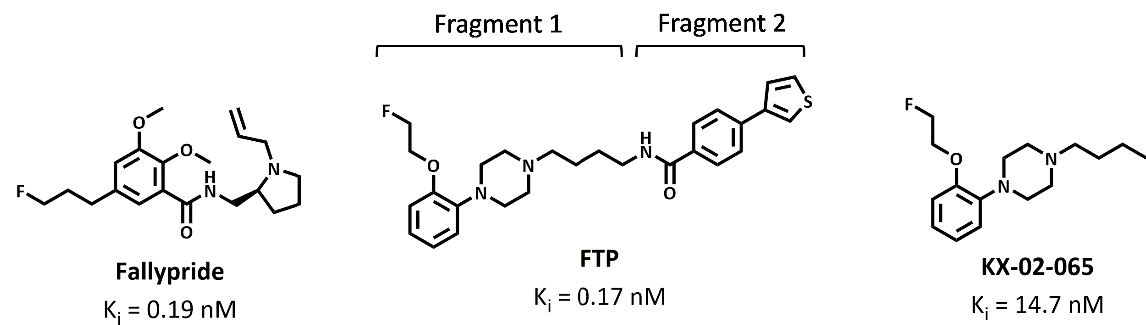
Figure 1. Structures and binding affinity of Fallypride, Fluortriopride (FTP), and KX-02-065 for human D 3 R [4,20].